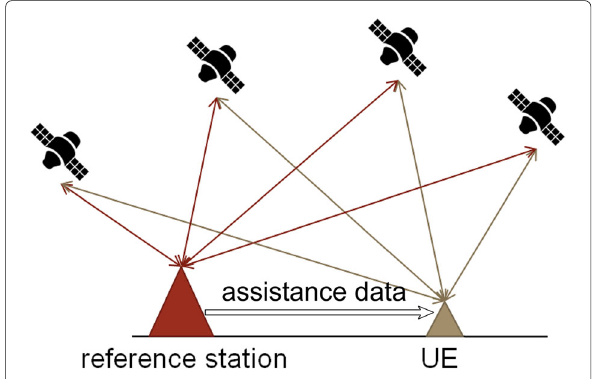
of GNSS signals, while best UE-satellite range accuracy achieved using code phase measurements is about 1